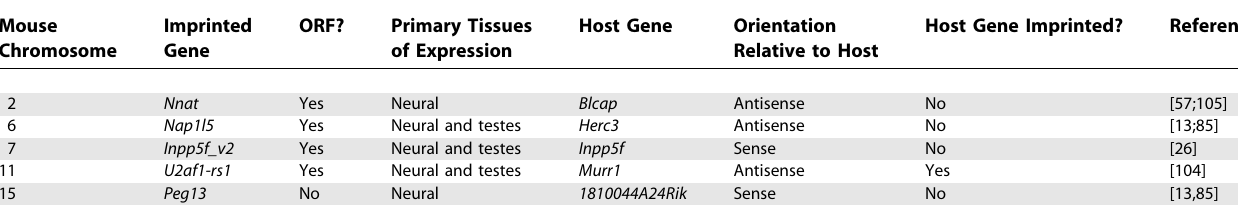
Table 1. Properties of the Five Known Microimprinted Domains in the Mouse. Mouse Imprinted Chromosome